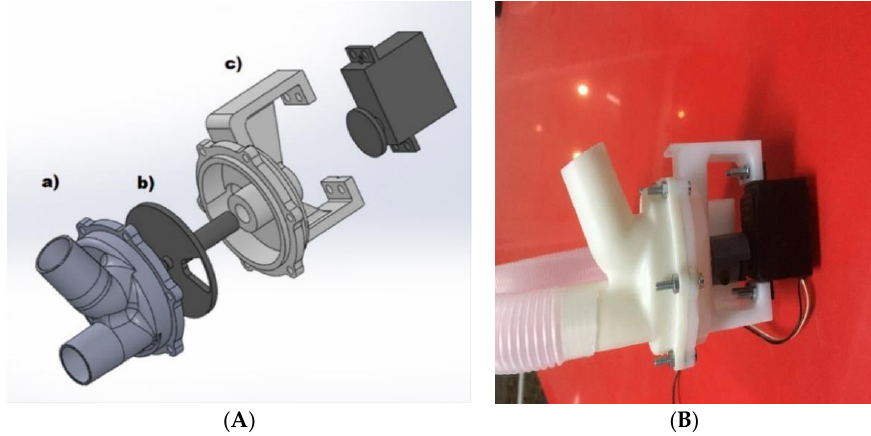
Figure 4. Developed three-way solenoid valve ( A ) 3D design: (a) main body detail; (b) rotating stem detail and (c) detail of the servo support and air chamber; ( B ) final appearance.